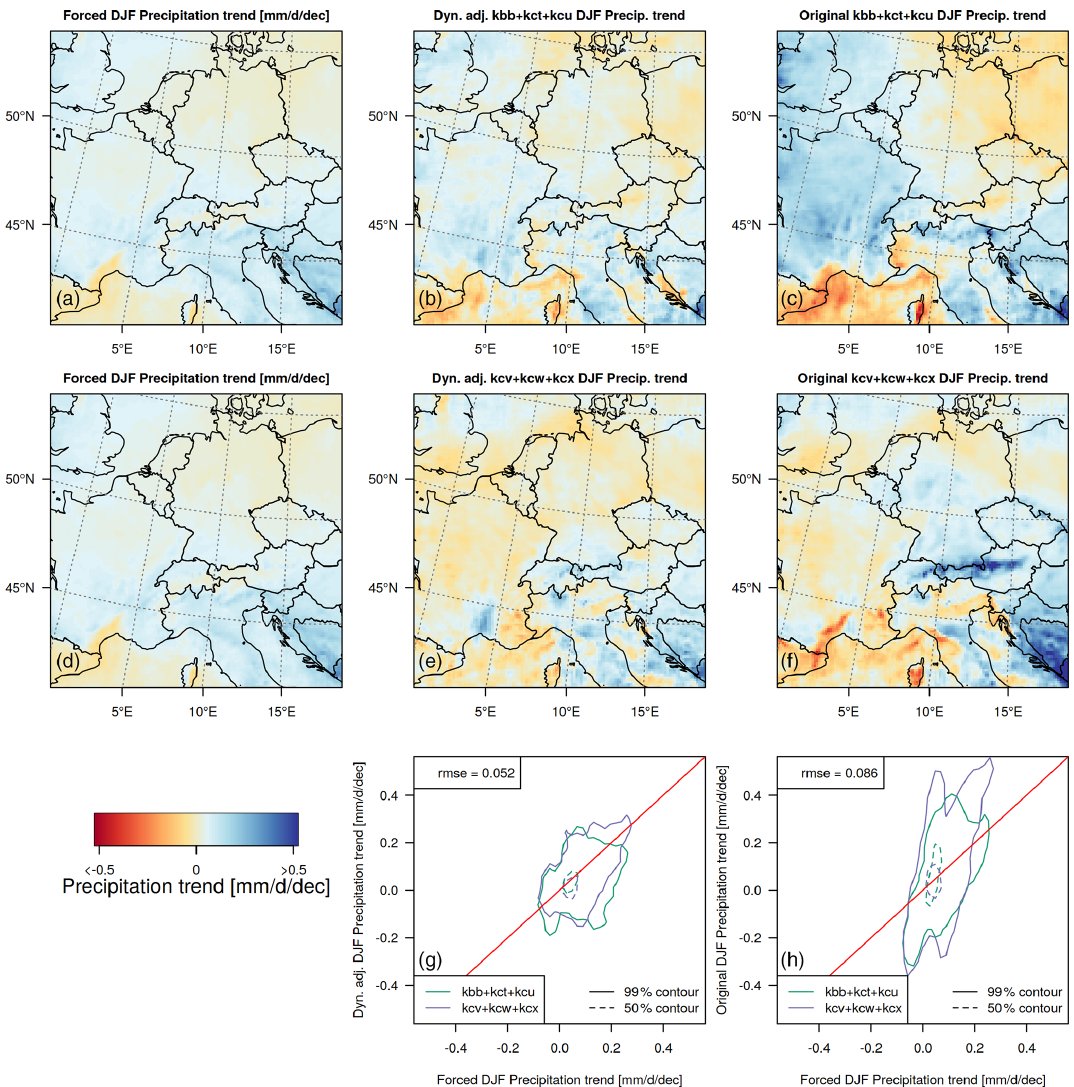
Figure 11. Dynamical adjustment of 50-year winter precipitation trends (2020–2069) under the “EOF1-” regime (25% of all days that project weakest on the first EOF). (a, d) Linear forced winter precipitation trends under the “EOF1-” regime (2020–2069). (b, e) Linear 50-year winter precipitation trends in an average of three randomly selected dynamically adjusted ensemble members. (c, f) Linear 50-year winter precipitation trends in an average of three corresponding original ensemble members. (g, h) Scatter plots of 50-year precipitation trends in the forced response against 50-year precipitation trends over land in dynamically adjusted (g) and originally simulated ensemble members (h)